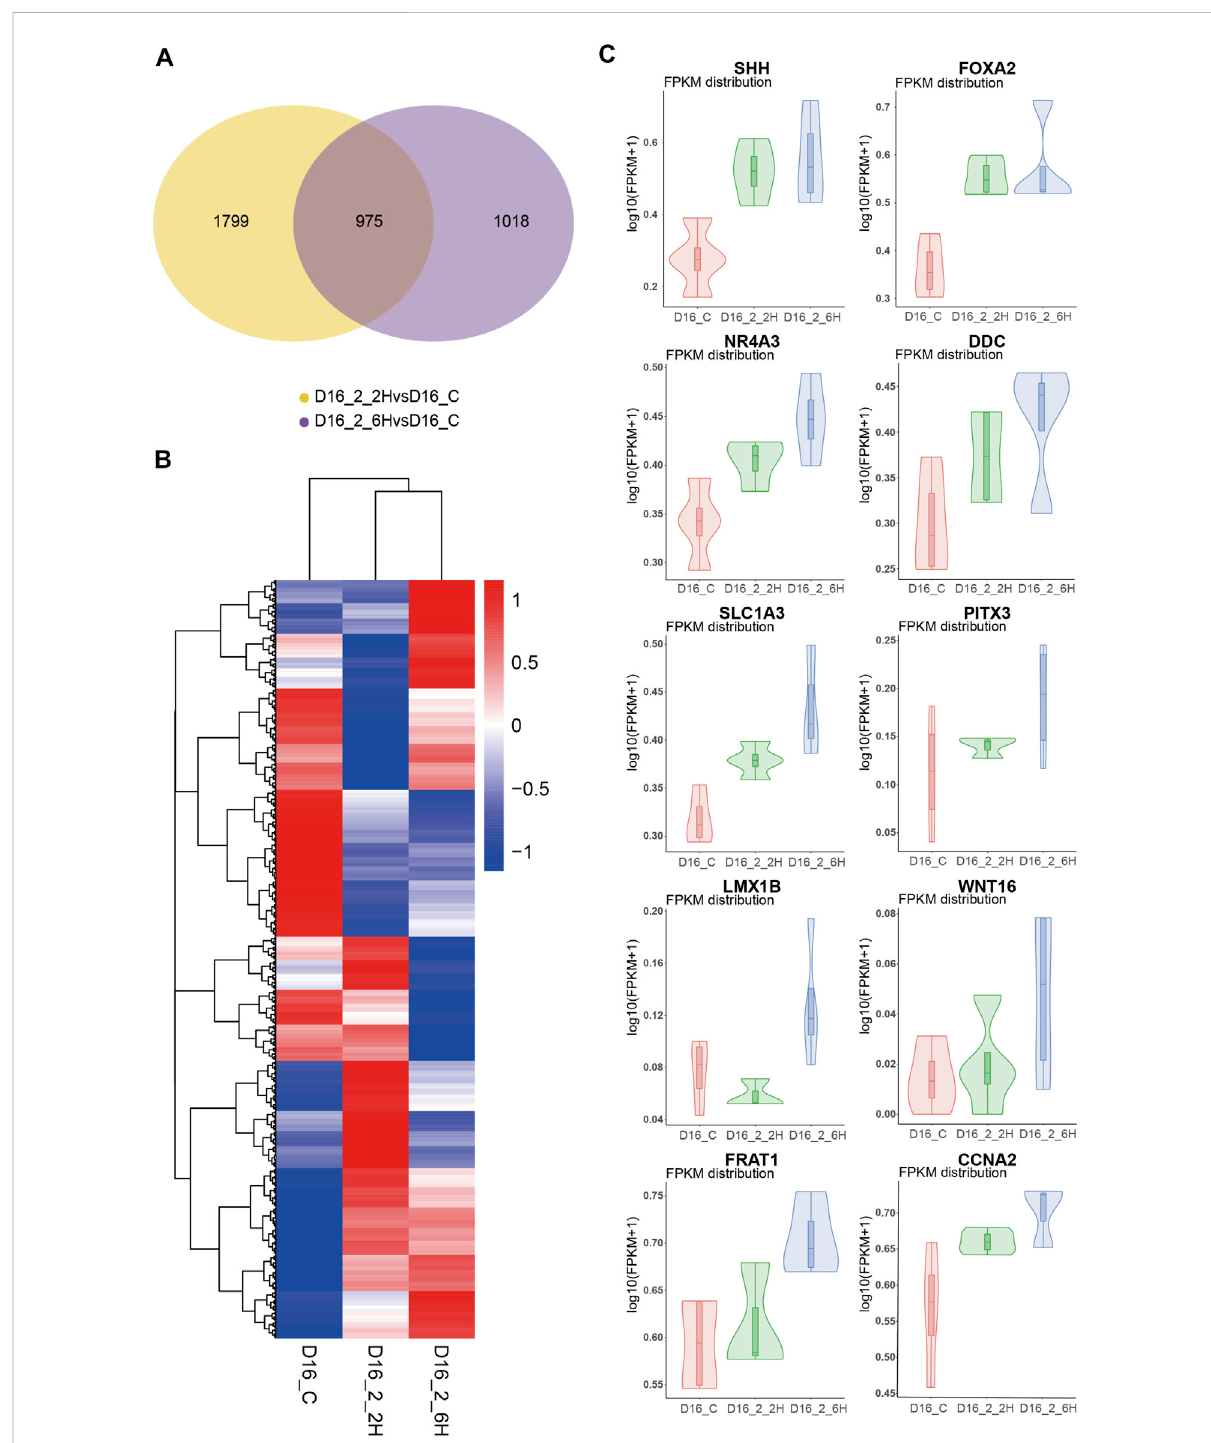
FIGURE 8 Mechanisms underlyingsevo fl uraneexposurefacilitatesthehMBOprogenitordifferentiation. (A) Vennanalysisshowedthedifferencebetween the difference genes of MBO-SF-2%2H and control group and difference genes of MBO-SF-2%6H group and control group. (B) Volcanic map showed the differential gene expression between the MBO-SF-2%6H group, the MBO-SF-2%2H group and the control groups. (C) Violin Plot showed the up-regulation of important transcription factors in the midbrain development of the MBO-SF-2%6H group, MBO-SF-2%2H group compared with the control